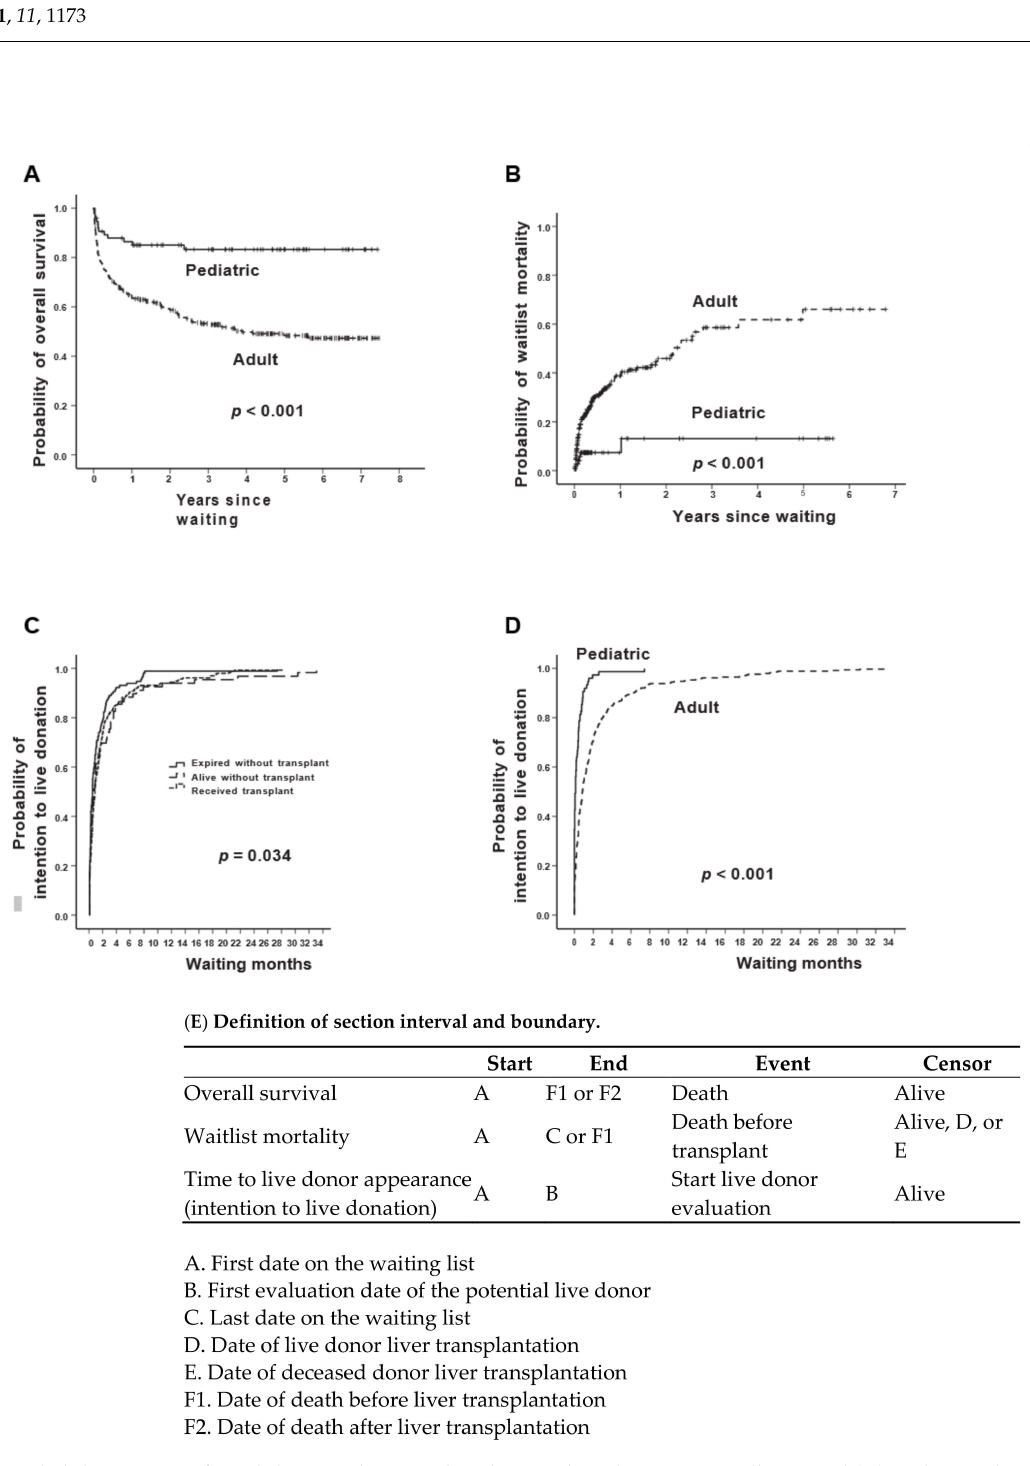
Figure 2. Probability curves of candidates with “intend to donate” live donors. Overall survival ( A ) and mortality rates for patients on the waiting list ( B ) in adult and pediatric subgroups. Occurrence of potential live liver donors in 3 subgroups (died, alive without transplant, and received transplant) ( C ) and in adult and pediatric subgroups ( D ). ( E ) Definition of section interval and